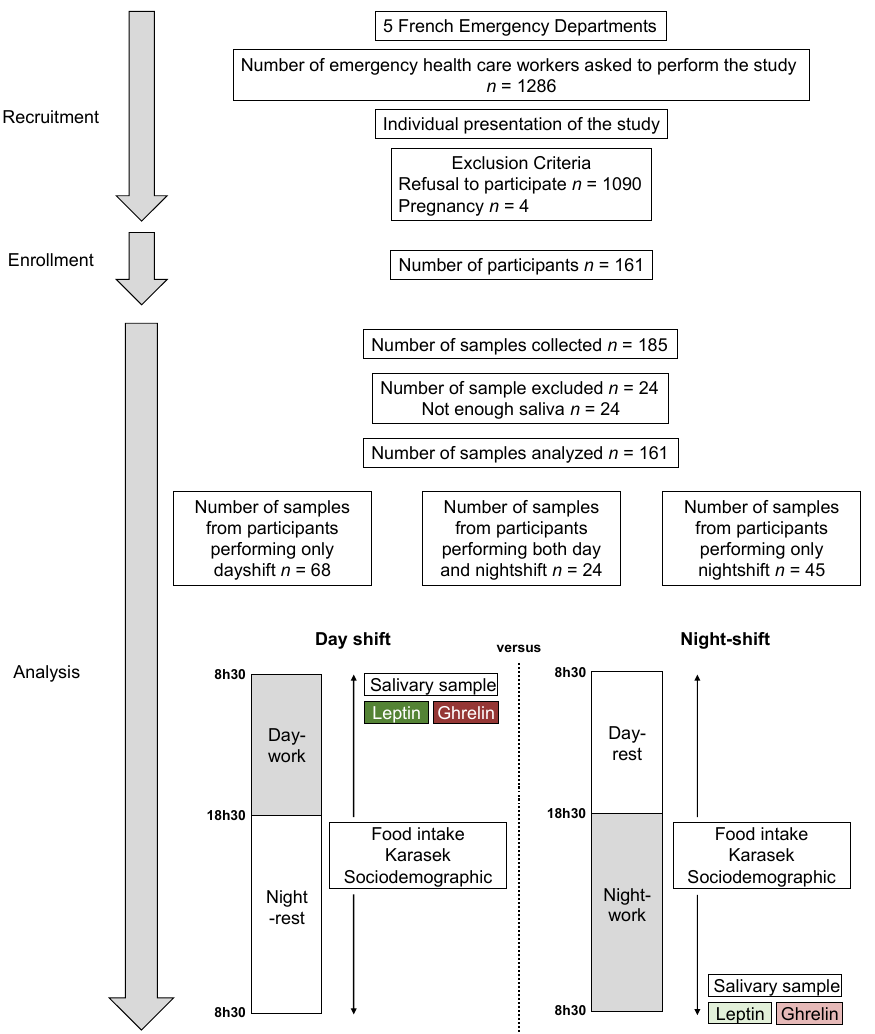
Figure 1. Study design. Among five French Emergency Departments, we were able to recruit 161 emergency healthcare workers for a total of 185 salivary samples. Twenty-four were excluded because of a low quantity of saliva. Ghrelin and leptin levels were assessed from 161 samples.